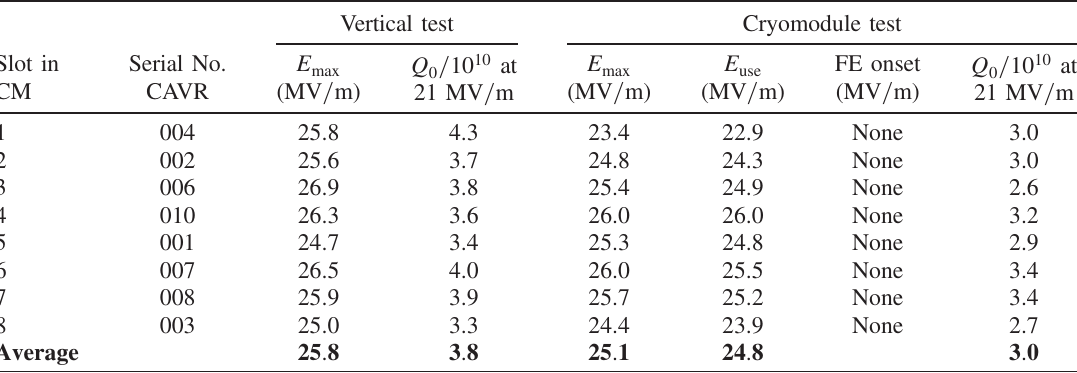
TABLE II. Summary of cavity performance in vCM and VT. The VT Q 0 values are corrected for stainless steel flange losses ( 0 . 8 n Ω subtracted, based on simulations). “ FE onset ” refers to the lowest gradient at which field emission was observed at the end of the